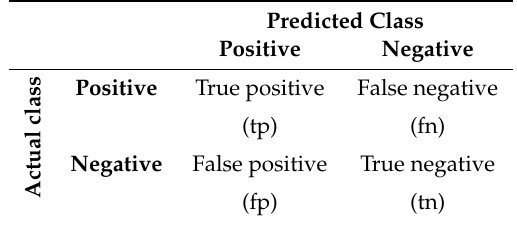
Table 1. Confusion matrix of a binary classification